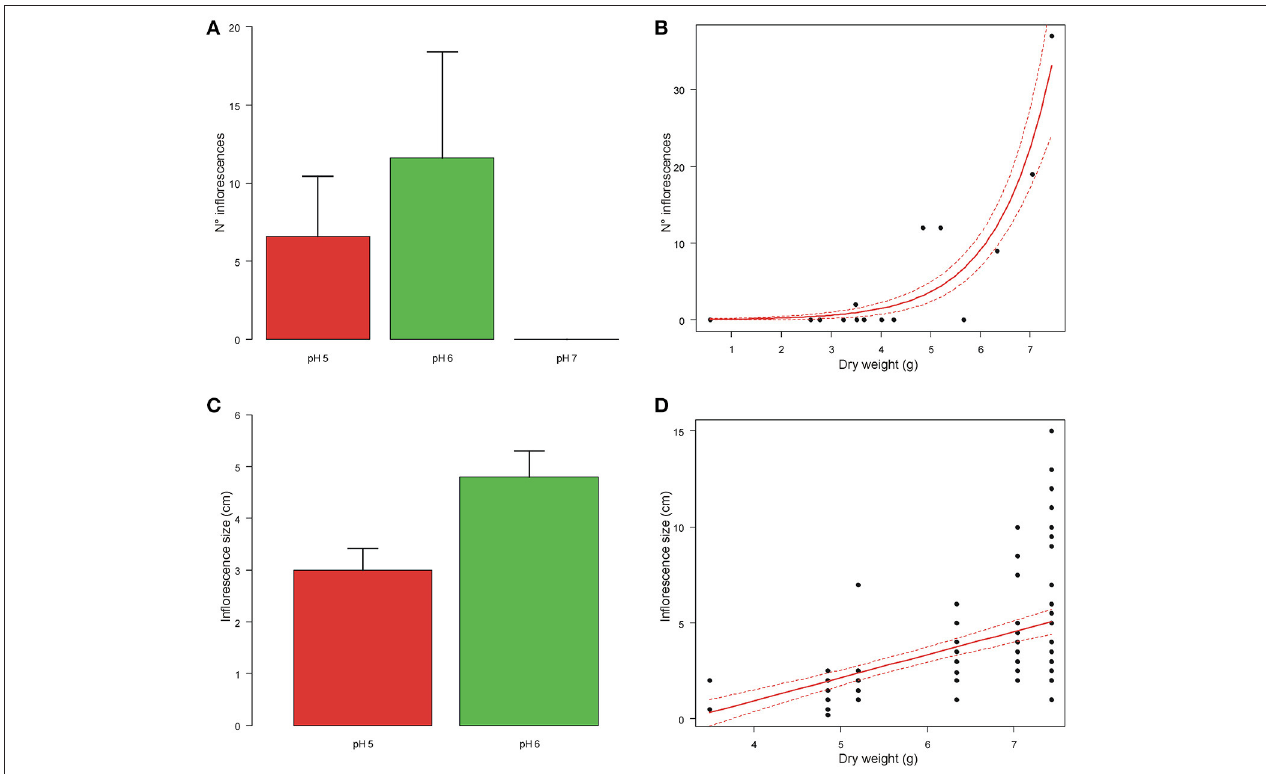
FIGURE 4 | Means number of inflorescences and inflorescence size of A. artemisiifolia under different pH values (A–C) . At pH7 the plants did not produce any inflorescences. Relationships between number of inflorescences and inflorescence size with dry weight of the aerial biomass (B–D) ; both parameters increased significantly with dry weight ( P < 0.001; P = 0.047,